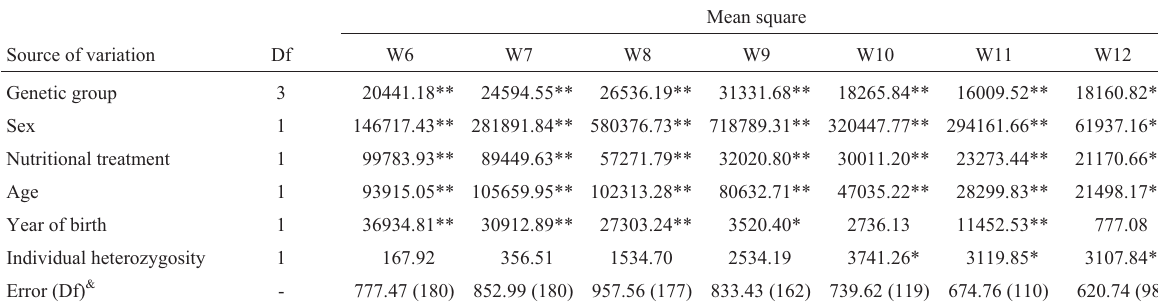
Table 4 - Summary of analysis of variance (ANOVA) for weights W6, W7, W8, W9, W10, W11 and W12.